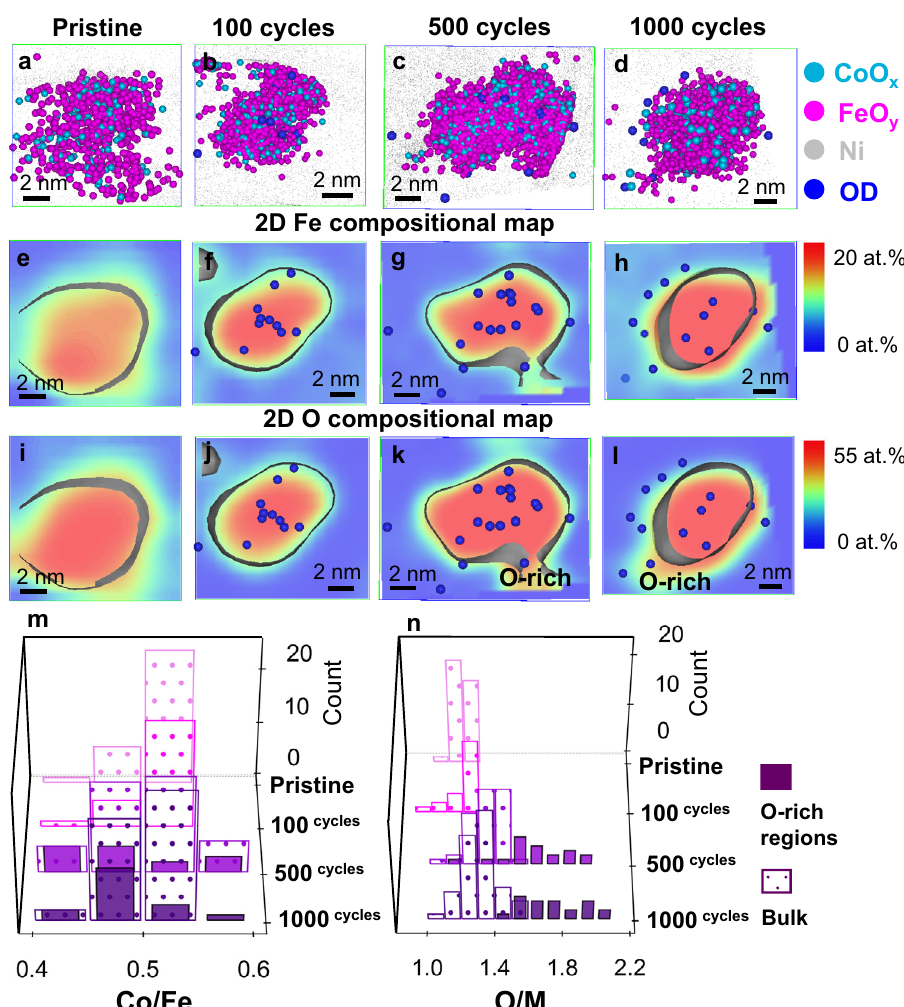
Fig. 6 Compositional evolution and elemental distribution of CoFe 2 O 4 during OER. a – d 3D atom maps, 2D compositional maps of e – h Fe and i – l O of non-segregated CoFe 2 O 4 nanoparticles in the pristine state and after 100, 500 and 1000 cycles, combined compositional histograms of m Co/Fe ratios and n O/M ratios (M = Co + Fe) in the O-rich nanoregions and the bulk part of non-segregated CoFe 2 O 4 nanoparticles in Supplementary Fig. 19a – d. (Source data of Fig. 6m, n are provided as a Source Data fi